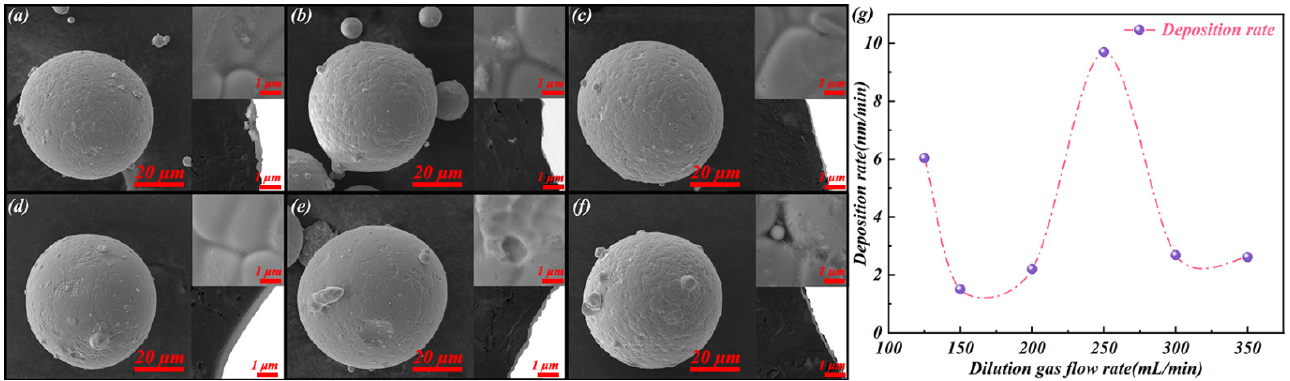
Figure 2. Surface morphology, partial enlargement morphology, and cross-sectional morphology of Fe–Si/SiO 2 composite particles deposited at 125 ( a ), 150 ( b ), 200 ( c ), 250 ( d ), 300 ( e ), and 350 ( f ) mL/min Ar-dilution gas flow rate; ( g ) SiO 2 layer deposition rate of particles prepared at various Ar-dilution gas flow rates.